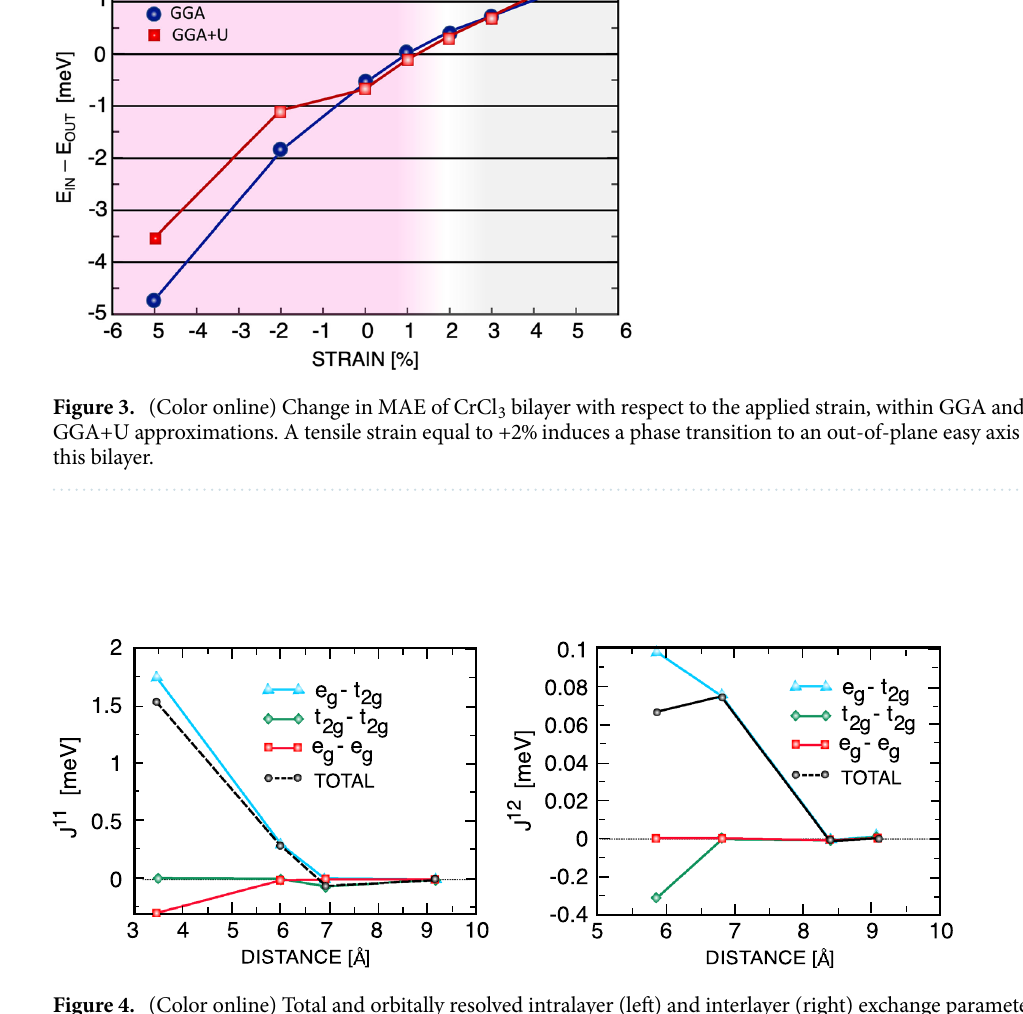
Figure 4. (Color online) Total and orbitally resolved intralayer (left) and interlayer (right) exchange parameters of bilayer CrCl 3